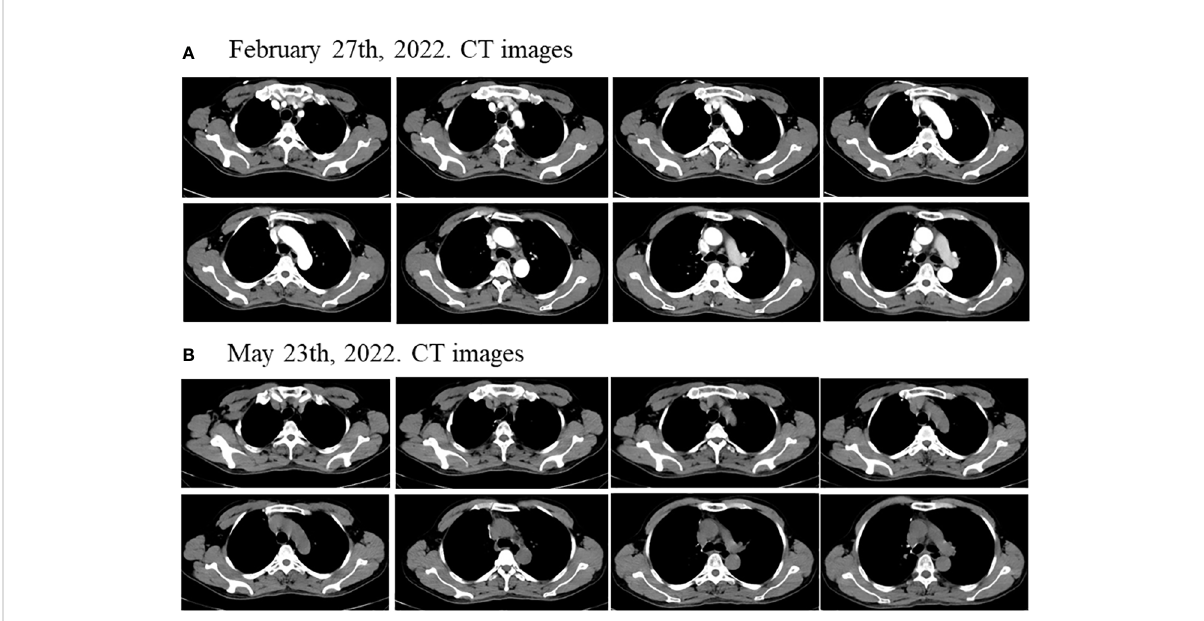
FIGURE 4 Disease status after surgical resection. The chest CT scan showed no evidence of malignant tumor recurrence about (A) 2.5 months and (B) 5.5 months after surgical